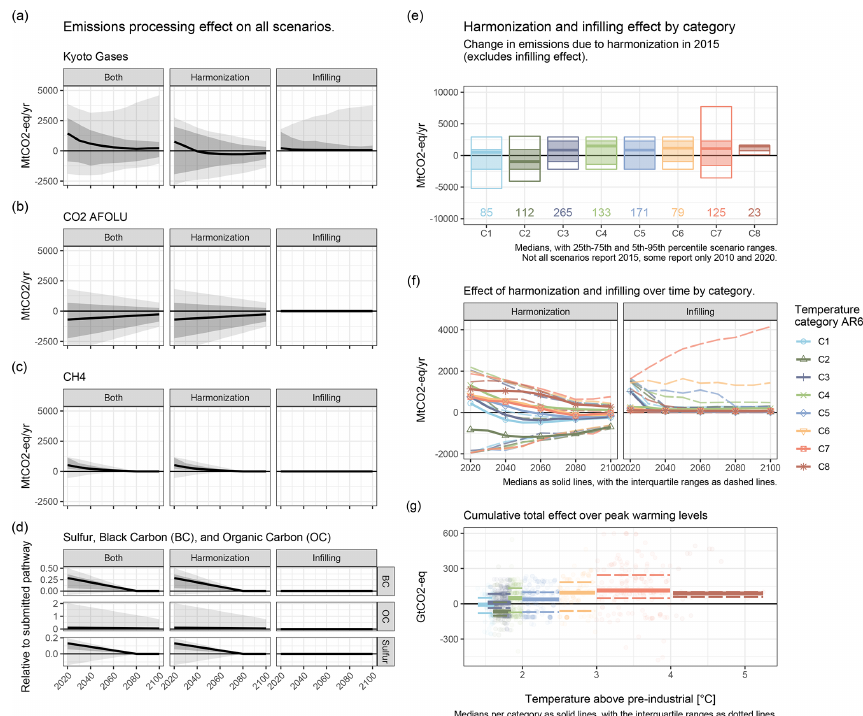
Figure 7. Effect of harmonisation and infilling processing steps on Kyoto gas emissions trajectories. Panel (a) – (c) : the effect of harmonisation and infilling over time on GHGs (Kyoto gases), CO 2 -AFOLU, and CH 4 for the full AR6DB. Panel (d) : the relative effect of harmonisation and infilling over time on BC, OC, and sulfur emissions for the full AR6DB. Panel (e) – (f) : effects of emissions processing by AR6 tempera- ture category. Panel (e) : the effect on GHGs in 2015 due to harmonisation. Panel (f) : the effect of harmonisation and infilling on GHGs over time. Panel (g) : the cumulative effect of emissions processing until 2100 over the projected global